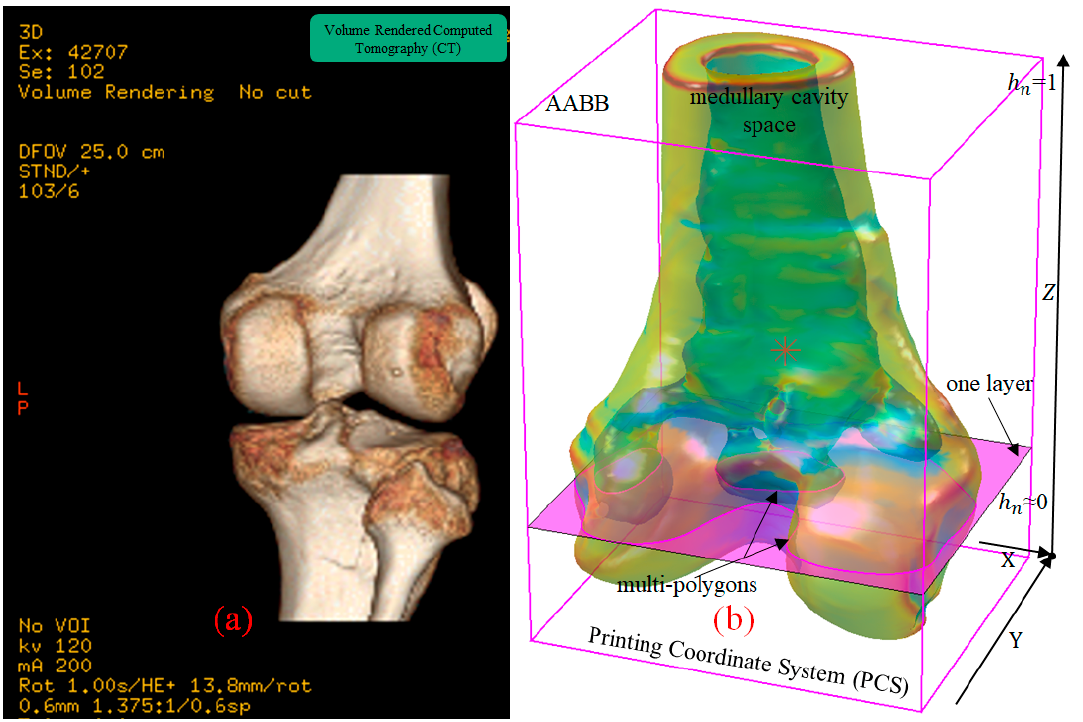
Figure 1. Printing Coordinate System (PCS) of 3D reconstructed human knee distal femur where ( a ) is volume-rendered human knee joint (posterior view) from CT and ( b ) is distal femur manifold model.